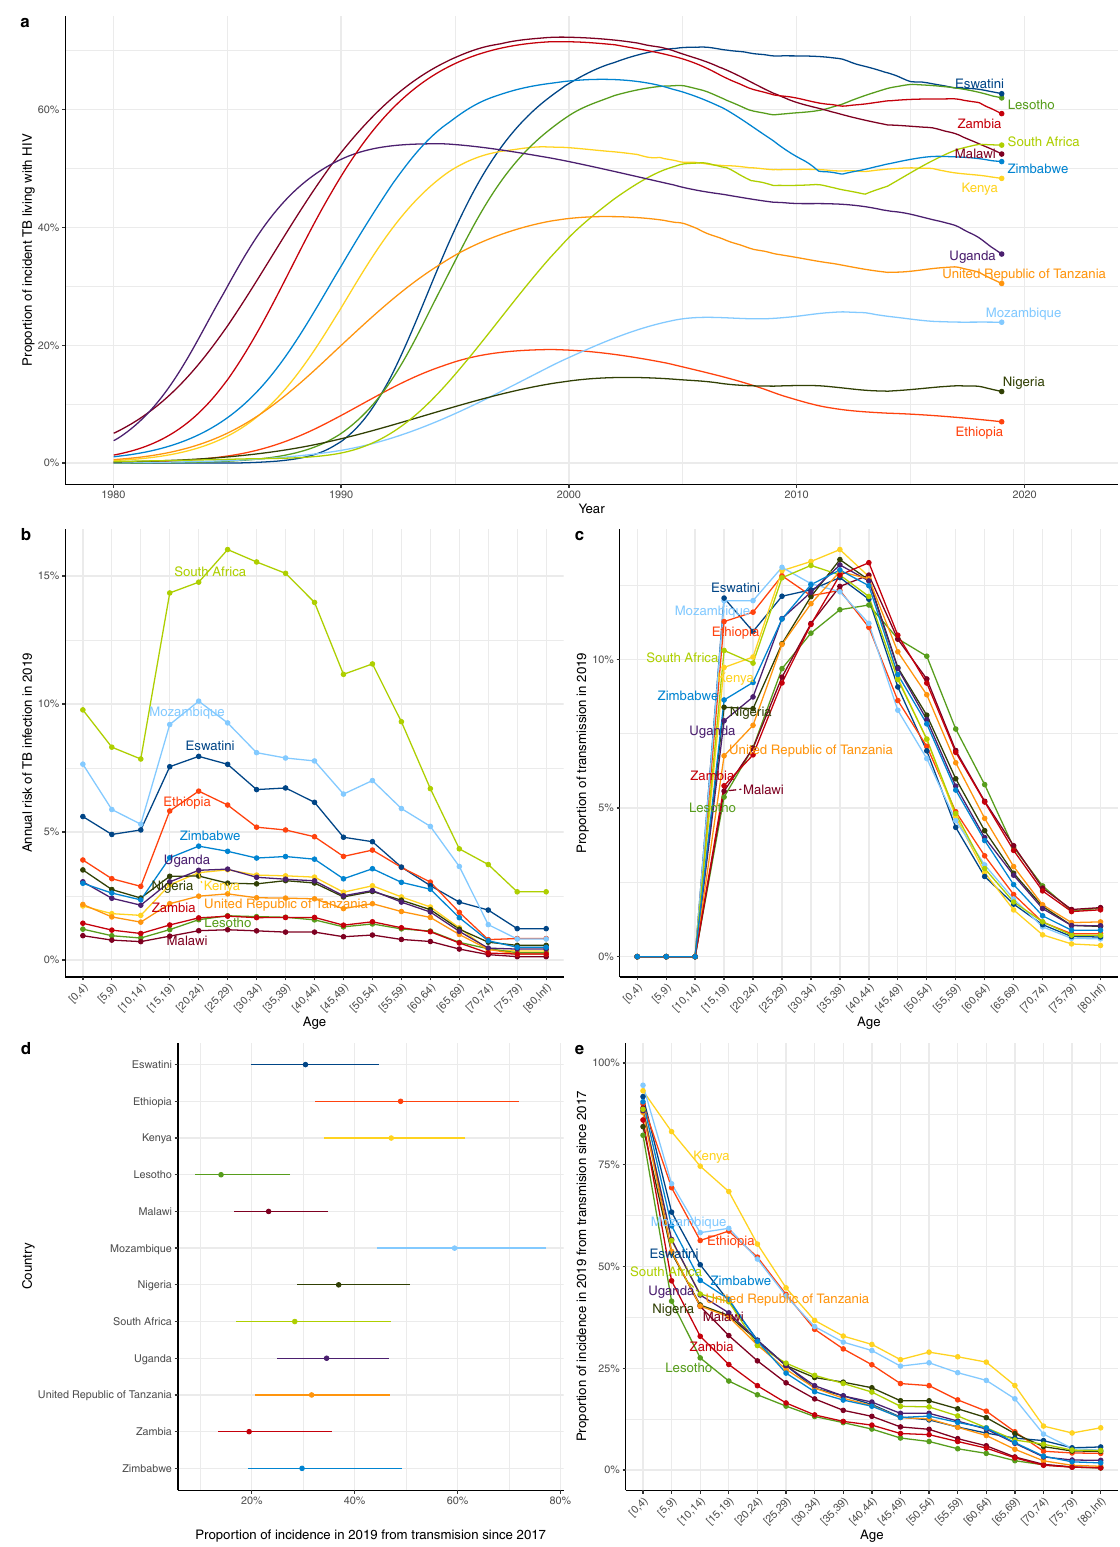
Fig. 5 | Estimatesofotherepidemiologicalmetrics.a The proportion of incident TB that is TB/HIV for 1980 – 2019. b Annual risk of TB infection in 2019 by age. c ProportionofTBtransmissionfromeachagegroupin2019. d ProportionofallTB incidence in 2019 due to (re)infection within 2 years (error bar=95% credible